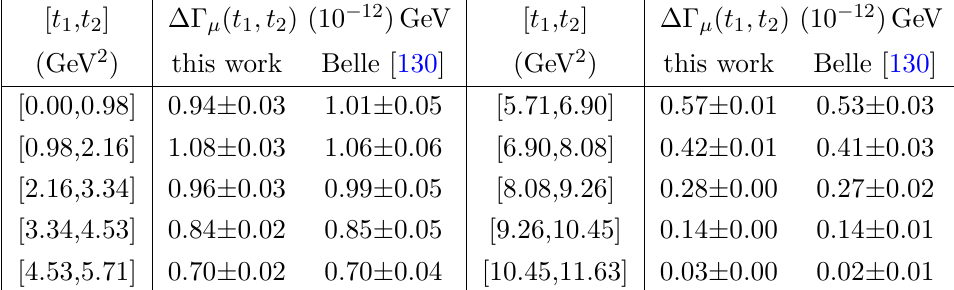
The binned (normalized) partial decay rate of B → D‘ν